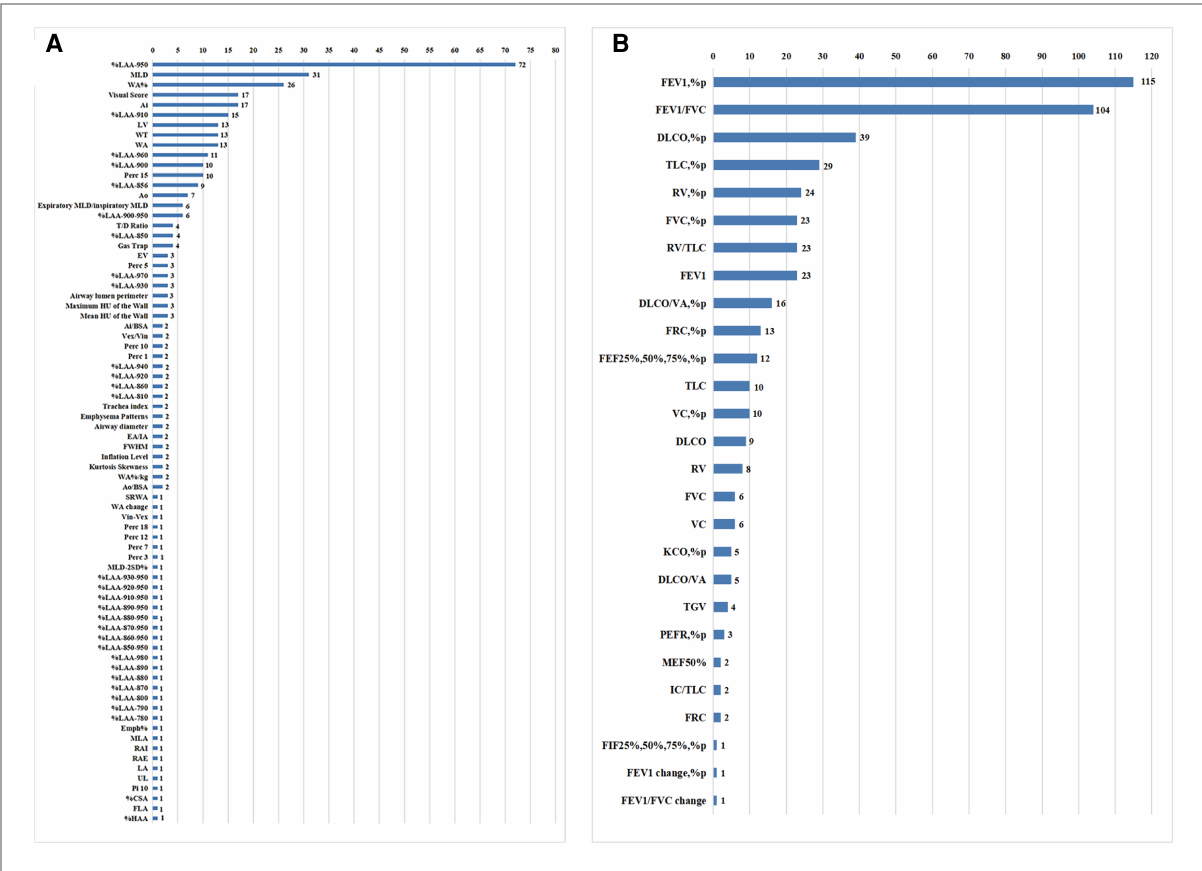
FIGURE 3 Counting of CT measurements and pulmonary function test parameters in the systematic review.